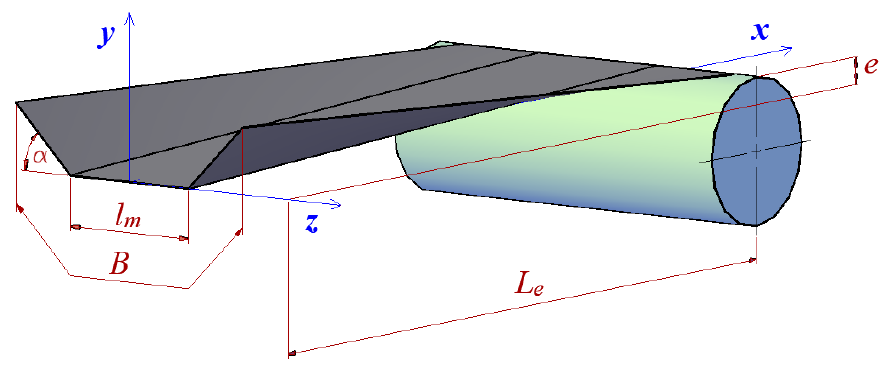
Figure 3. Transition section of the belt conveyor ( L e —length of the transition section; B —belt width; α —trough angle; l m —length of the central part of the belt trough; e —height difference between the contour of the pulley coat and the central part of the trough).